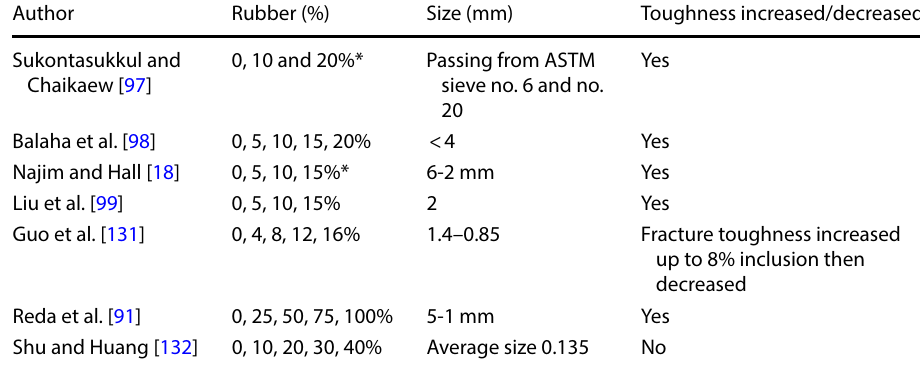
Table 9 Toughness of concrete containing CR